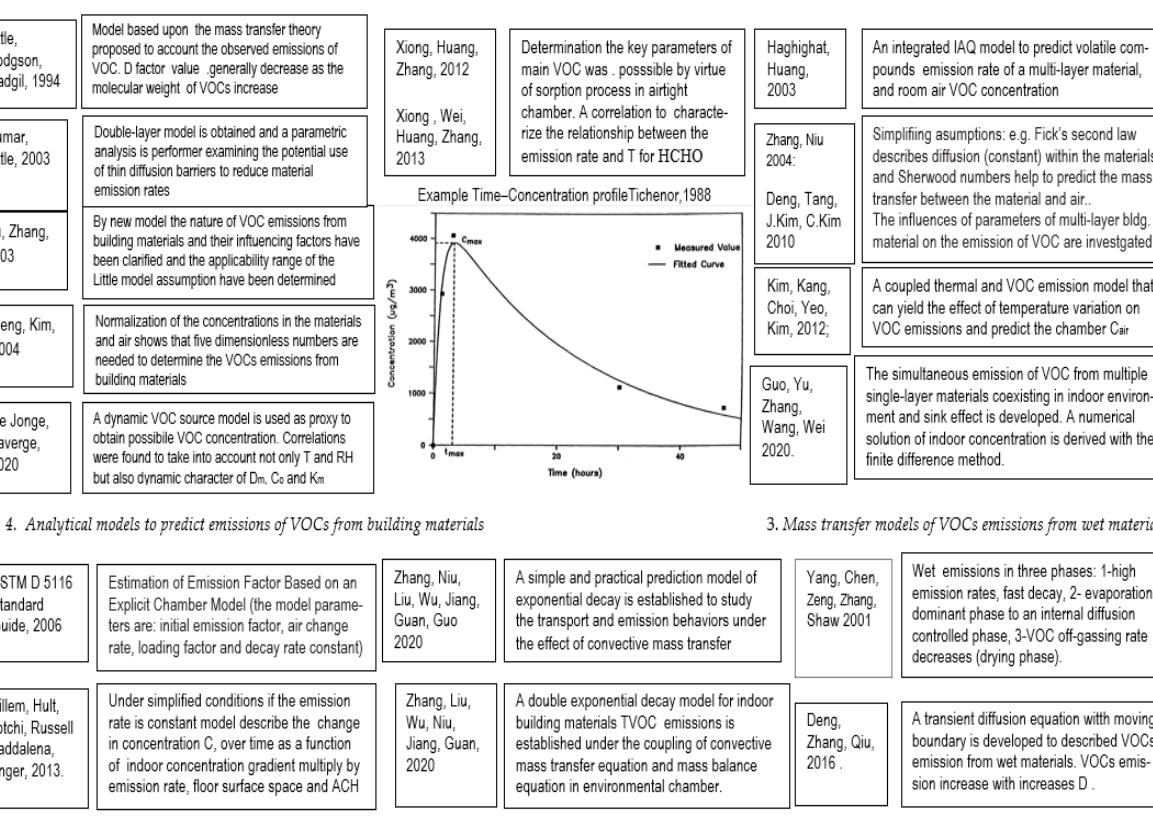
Figure A1. Four types of models to predict the emission of VOCs from construction materials.